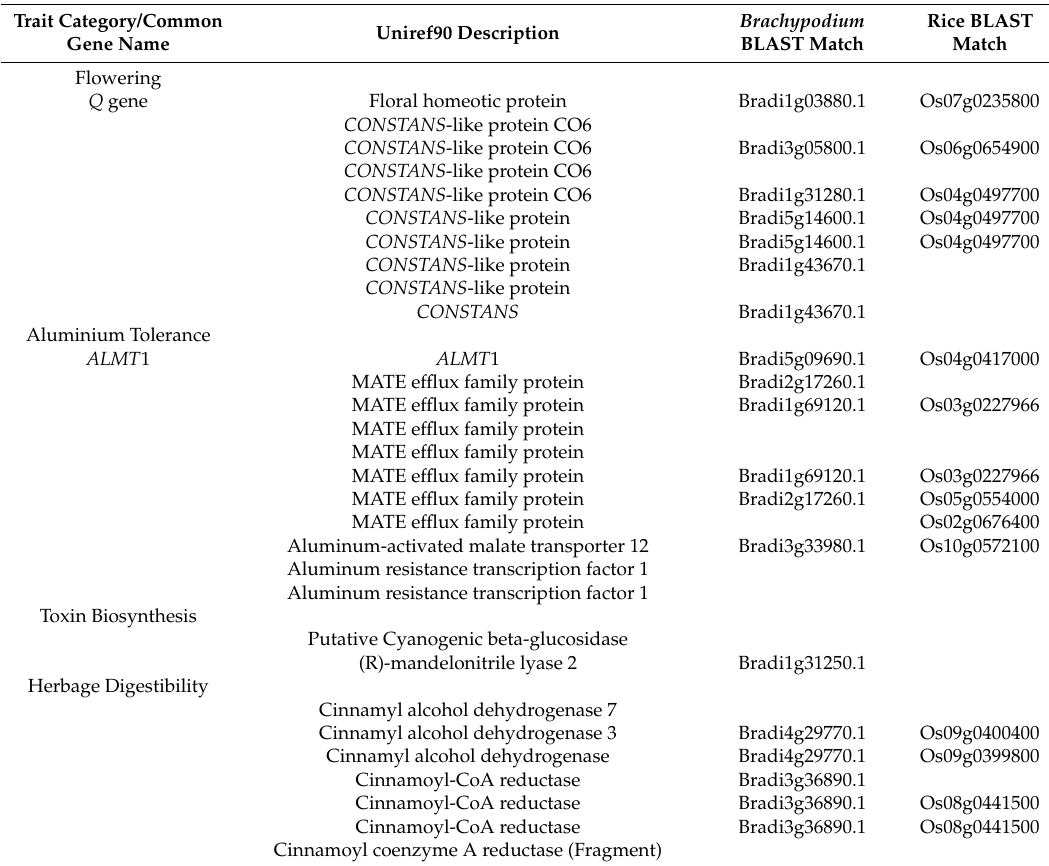
Table 2. Summary information on identification of candidate genes for key agronomic traits. MATE, multidrug and toxic compound